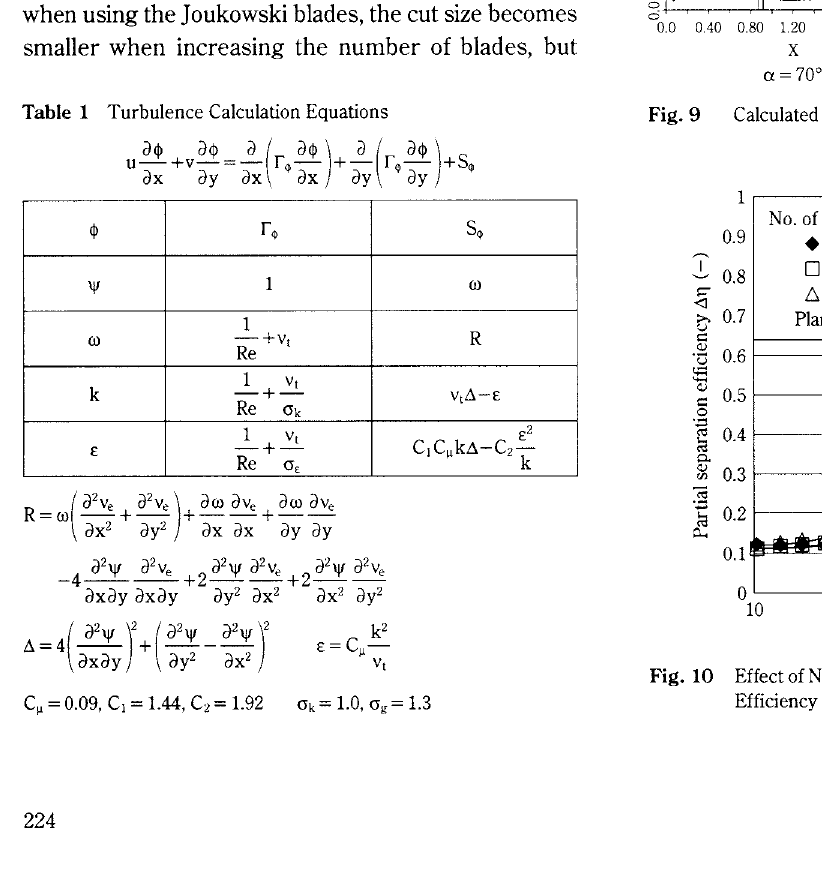
Calculated Fluid Velocity Distributions (a=70°, a=60°)